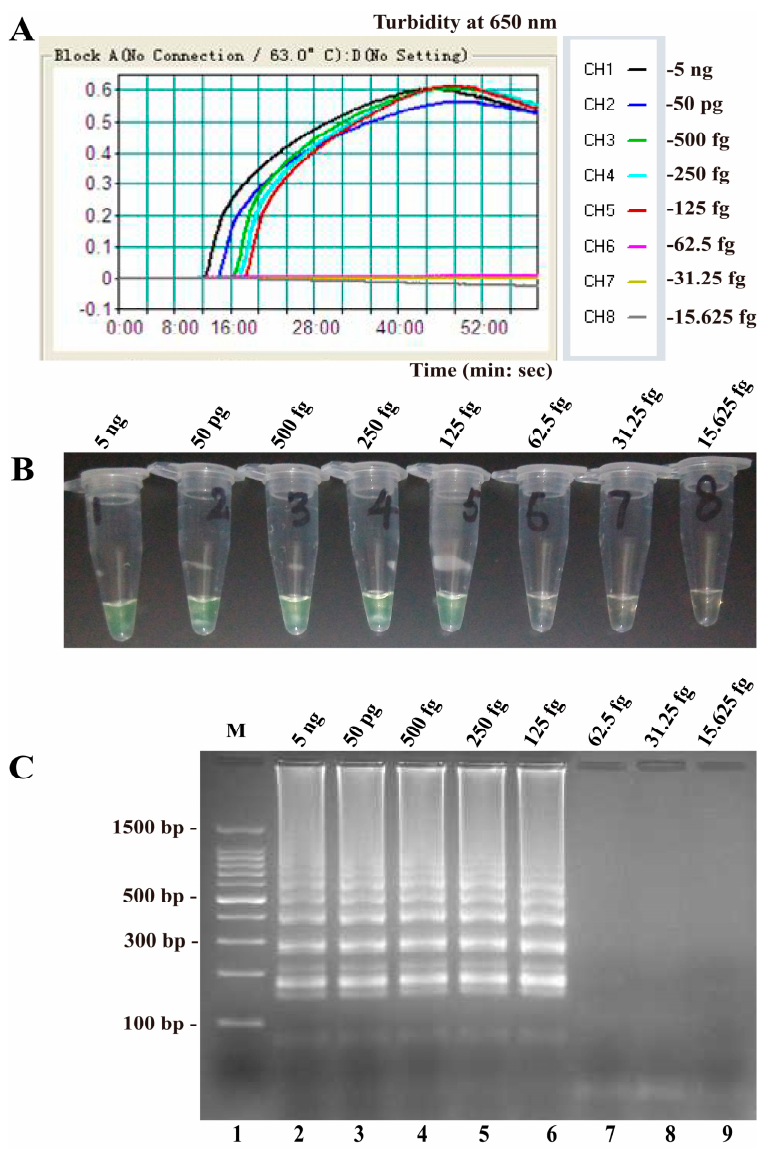
Figure 5. Sensitivity of the LAMP assay using serially diluted genomic DNA of B. quintana as template: ( A ) Sensitivity of the LAMP for B. quintana detection was analyzed by real ‐ time measurement of turbidity; ( B ) The LoD for the LAMP assay was 125 fg genomic DNA per reaction; and ( C ) sensitivity of the LAMP for B. quintana detection wase seen using gel electrophoresis. Lane M, DL 50-bp DNA marker. The positive results were observed as a ladder ‐ like pattern on 2.5% agarose gel electrophoresis analysis.